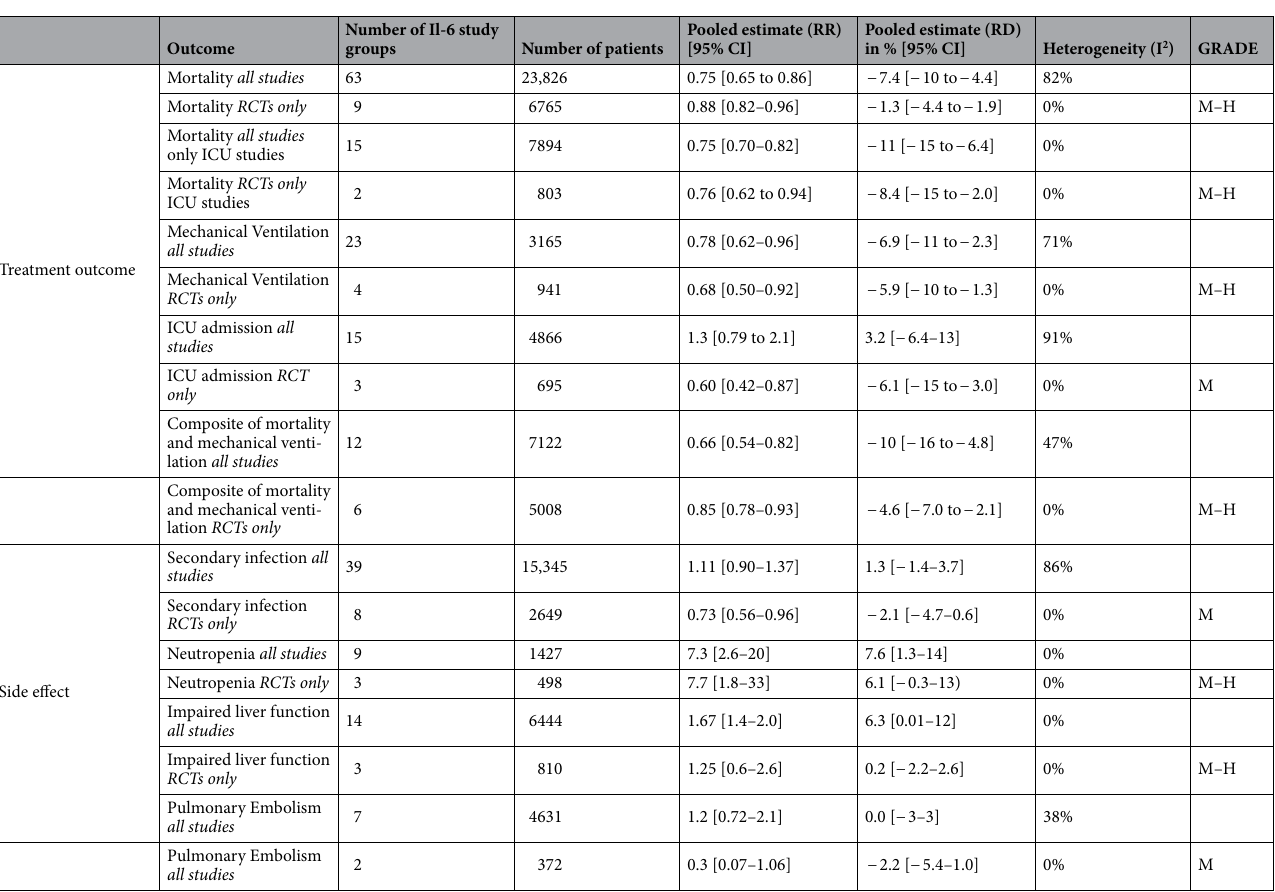
Table 1. summary of data synthesis. RR risk ratio; defined as: risk tocilizumab group/risk control group, RD risk difference; defined as: risk tocilizumab group—risk control group. 95% CI 95% confidence interval, M moderate certainty, M–H moderate to high